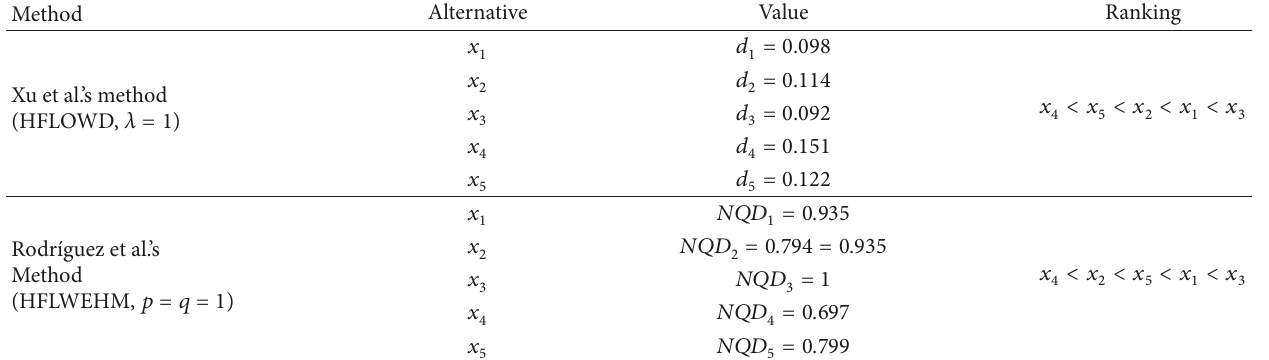
Table 11: Decision making